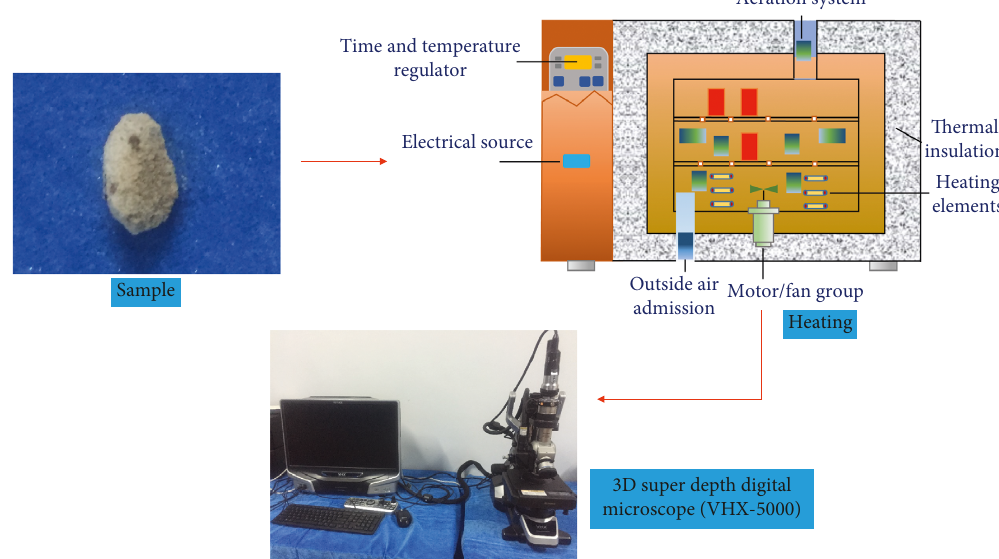
Figure 14: The heating test process of MCS material.